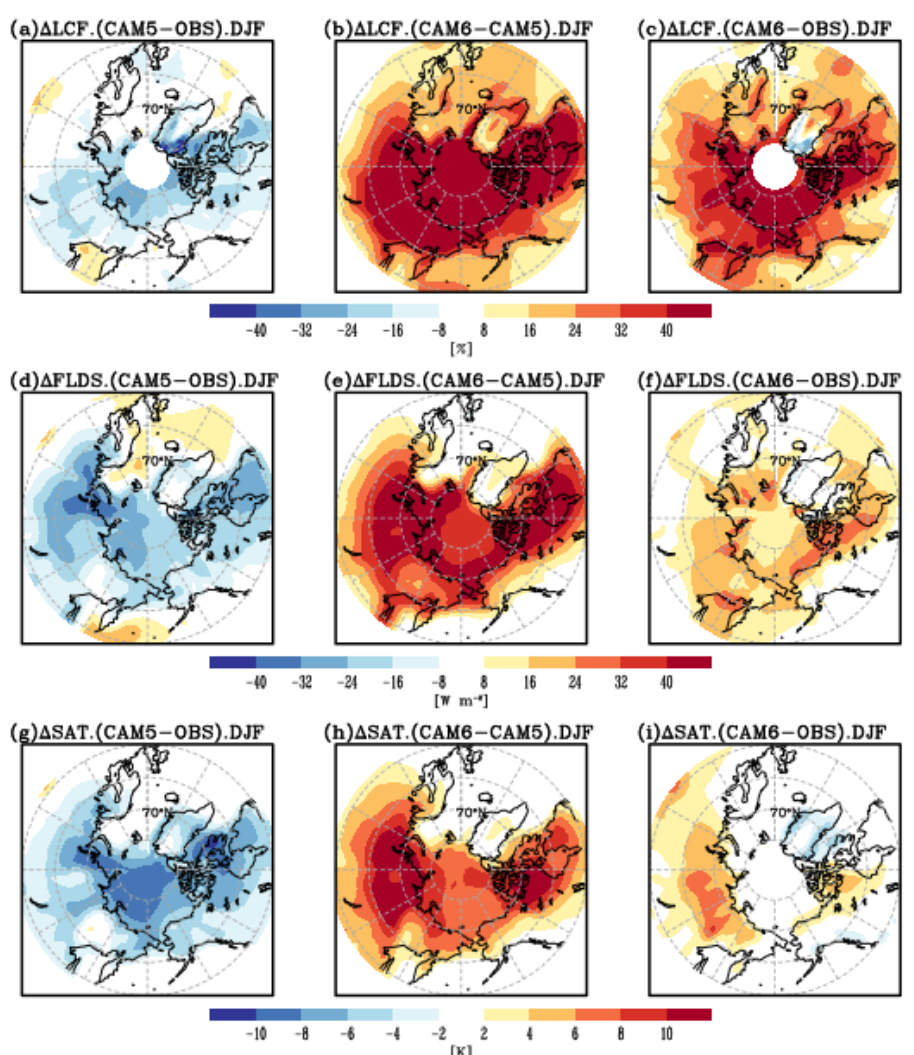
Figure 7. Biases of ( a – c ) low cloud fraction (LCF) against the CALIPSO – GOCCP observation, ( d – f ) downward longwave (LW) radiative flux at the surface (FLDS), ( g – i ) surface air temperature (SAT) against the ERA-Interim reanalysis during DJF obtained from ( left ) CAM5 and ( right ) CAM6, and ( center ) the differences in each variable between CAM6 and CAM5.